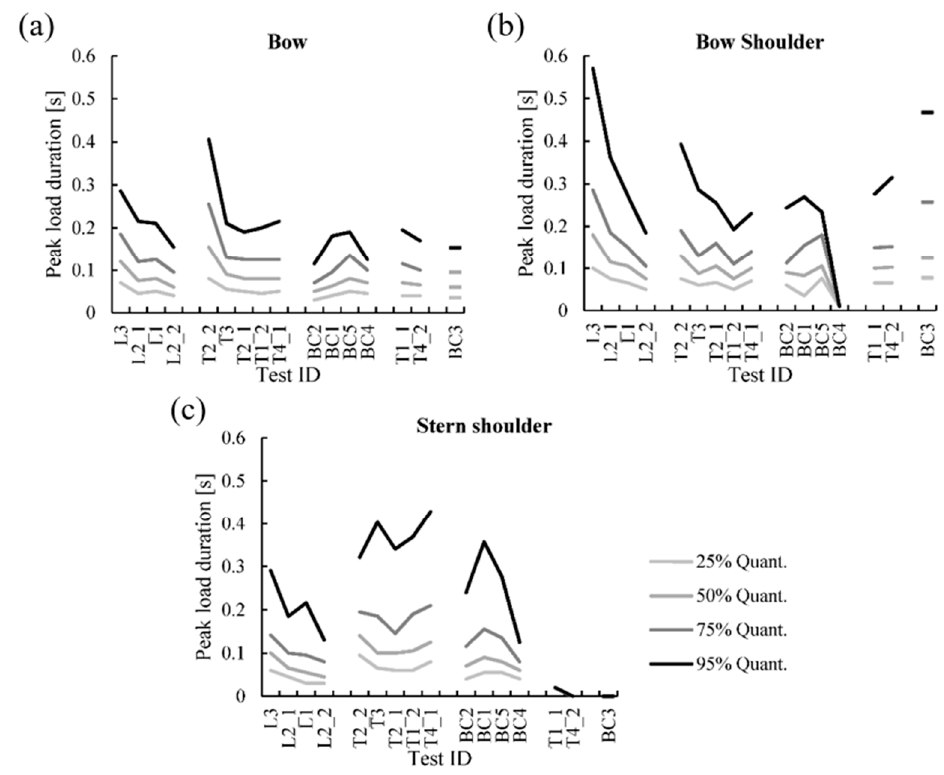
Figure 15. The 25%, 50%, 75%, and 95% quantiles of measured peak ice-induced load duration at ( a ) bow, ( b ) bow shoulder, and ( c ) stern shoulder.